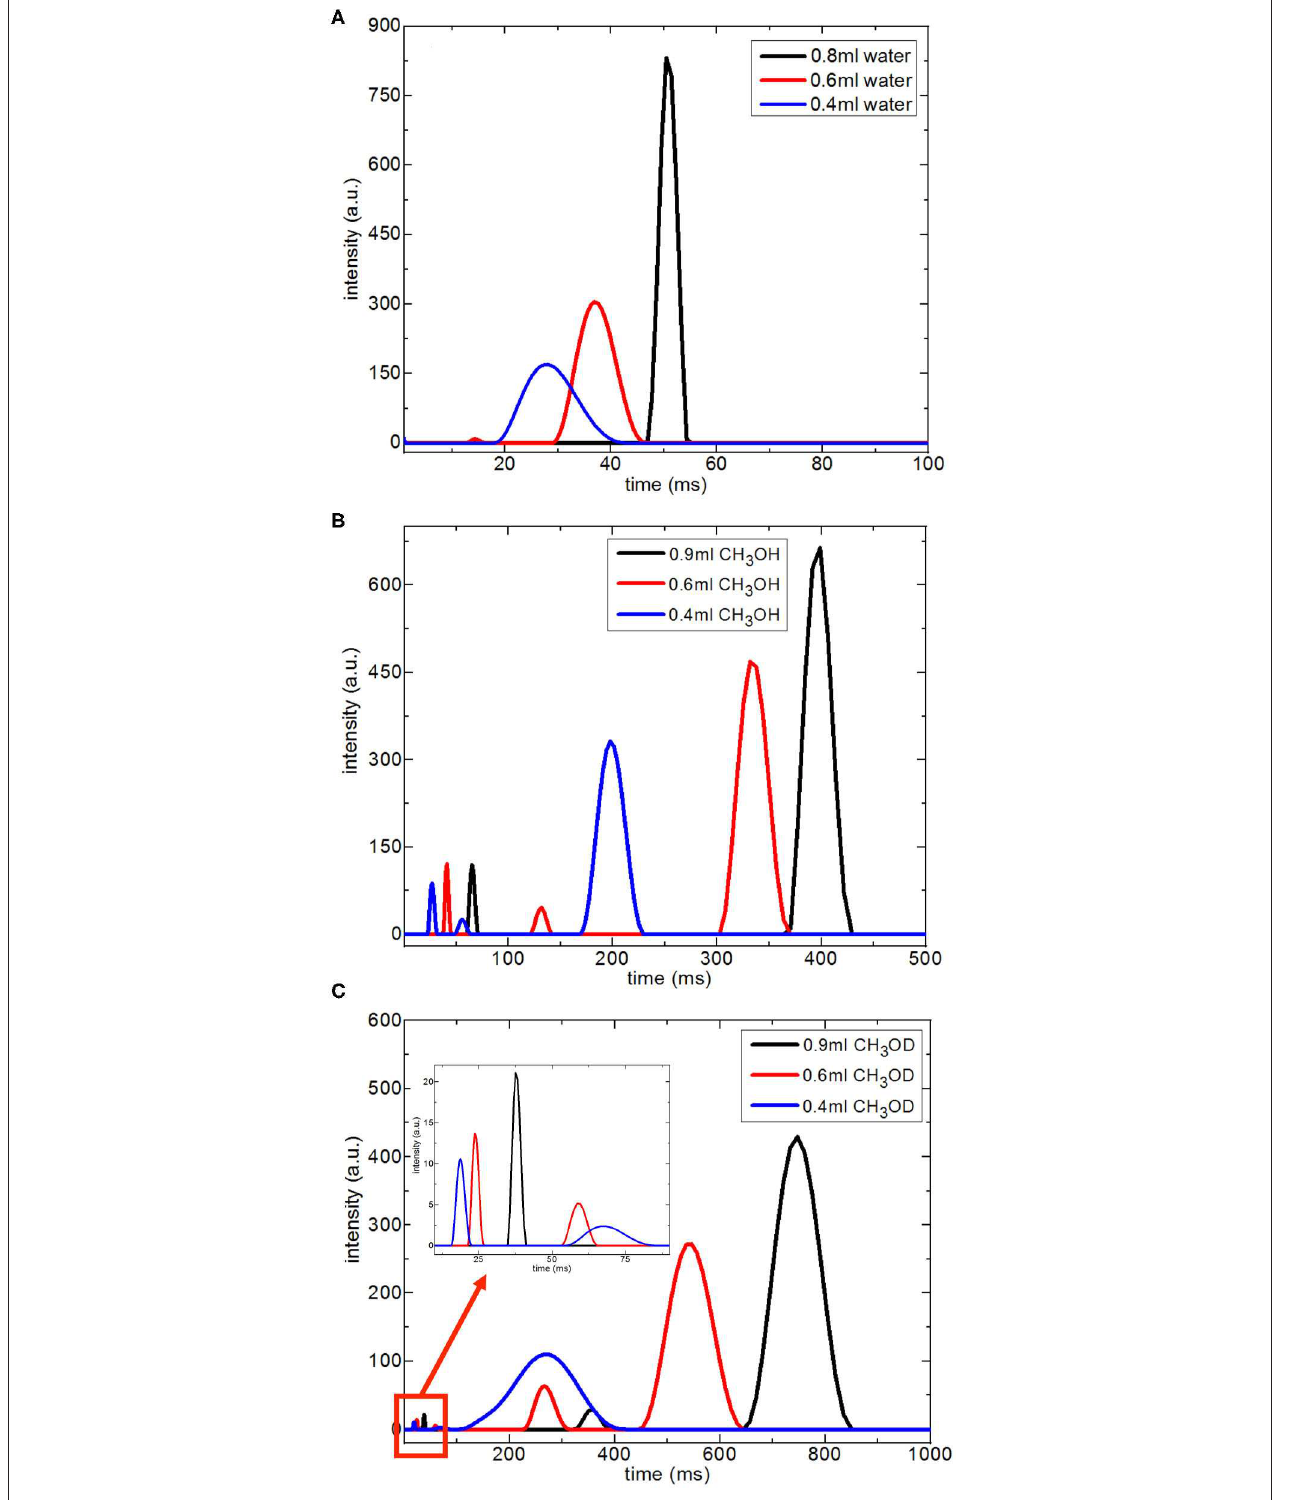
FIGURE 7 | Continuous T 2 relaxation time data for H 2 O (A) , CH 3 OH (B) , and CH 3 OD (C) confined into silica-4.0nm with the amount of 150mg and S/V = 574 as a function of fluid-to-solid ratio.